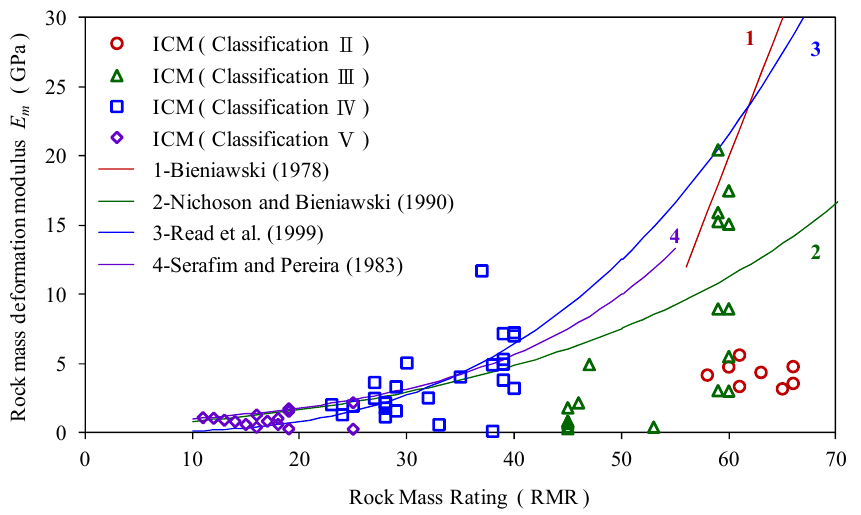
( b ) Figure 10. Comparison of the interaction behavior of support-ground between DCM and FEM at the section of observation ( a ) SP15 of the New Nanao tunnel, and ( b ) YNS15 of the New Youngchun tunnel. 5.4. Results Obtained by the Inverse Analysis (ICM) After all inverse calculations of the 68 sections of observation, it is evident that the 68